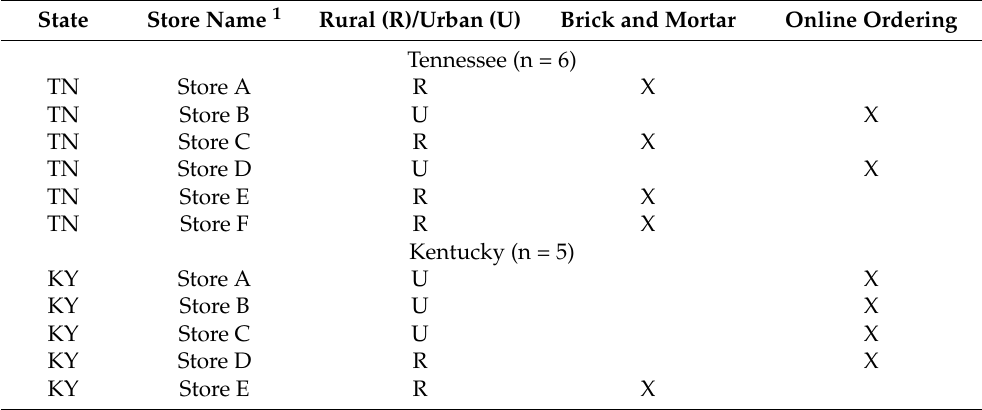
Table 1. Grocery store manager interview store locations and operating capacity by county